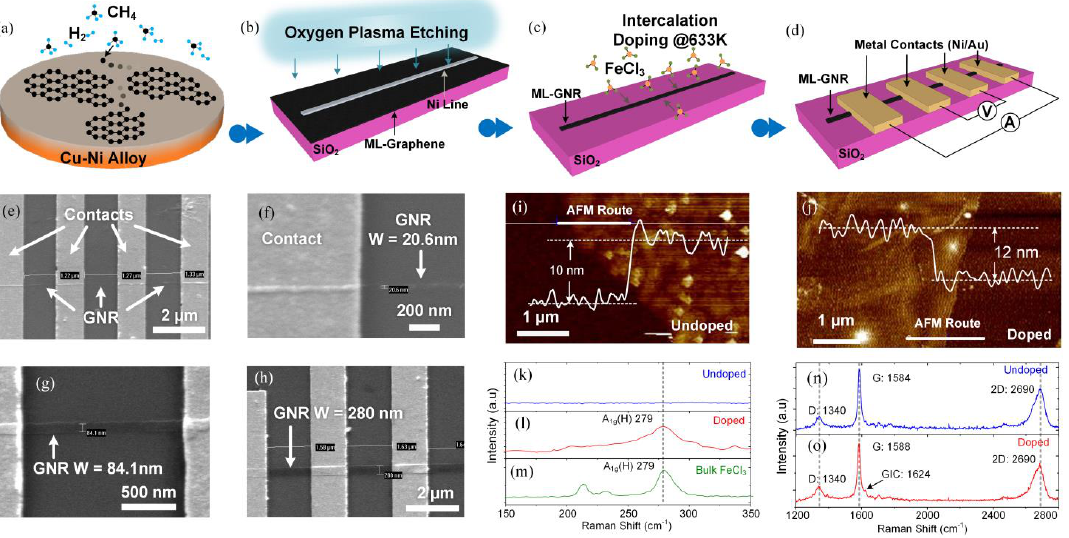
Figure 2. (a) Schematic of ML-graphene growth on Cu-Ni alloy catalyst by Carbon surface segregation. (b) Transferred ML-graphene on SiO 2 and oxygen plasma etching with Ni line mask. (c) FeCl 3 intercalation doping in Ar atmosphere at 633 K and 1.0-1.4 atm. (d) 4-probe test Figure 6. ( a ) Schematic of multilayer (ML)-graphene growth on Cu–Ni alloy; ( b ) Transferred structure. (e), (f) SEM images of 4-probe test structure, with patterned GNR with 20.6 nm width. SEM image of GNR with (g) 84.1 nm and (h) ML-graphene on SiO 2 substrate followed by oxygen plasma etching with Ni line mask; ( c ) FeCl 3 280 nm width. AFM image of (i) undoped ML-graphene and (j) 10-hour FeCl 3 intercalation doped ML-graphene, indicating a 20% increase in thickness after intercalation doping. The Raman spectrum of (k), (n) undoped ML-graphene, (l), (o) FeCl 3 intercalation doped ML-graphene, and intercalation doping at 633 K; ( d ) Four-probe test structures; SEM images of ( e ) four-probe test structure (m) bulk FeCl 3 . D, G, and 2D peaks are marked, indicating ML-graphene and the existence of defects normally observed in CVD ML-graphene. with patterned GNR; ( f – h ) GNRs with 20.6, 84.1, and 280 nm width. AFM image of ( i ) undoped The A 1g (H) Raman peak (34) is identified in both intercalation doped ML-graphene and bulk FeCl 3 , indicating the existence of FeCl 3 in doped ML- graphene. The existence of GIC peak (26) also confirms the intercalation. 633 nm wavelength laser was used in all the Raman measurements. ML-graphene and ( j ) 10 h FeCl 3 intercalation doped ML-graphene, indicating a 20% increase in ACS Paragon Plus Environment thickness after doping; The Raman spectrum of ( k , n ) undoped ML-graphene, ( l , o ) FeCl 3 intercalation doped ML-graphene and ( m ) FeCl 3 . Reproduced with permission from [28]. The American Physical Society,